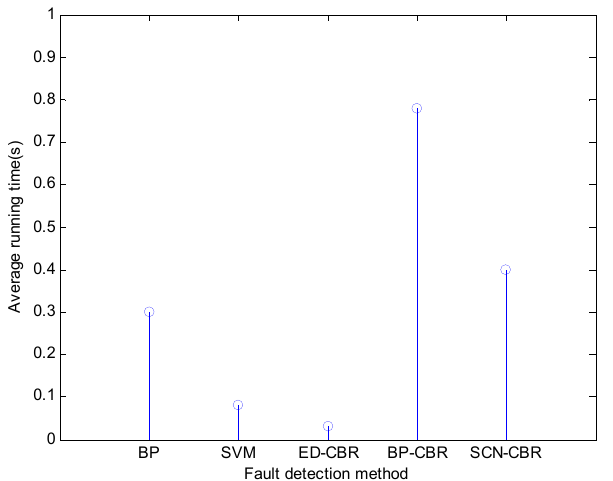
Figure 6. The running time of different methods for steam-water system fault detection ( s ).